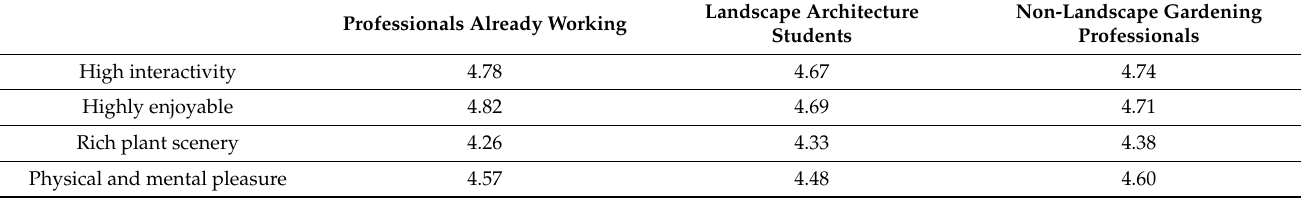
Table 2. Distribution of Respondents.